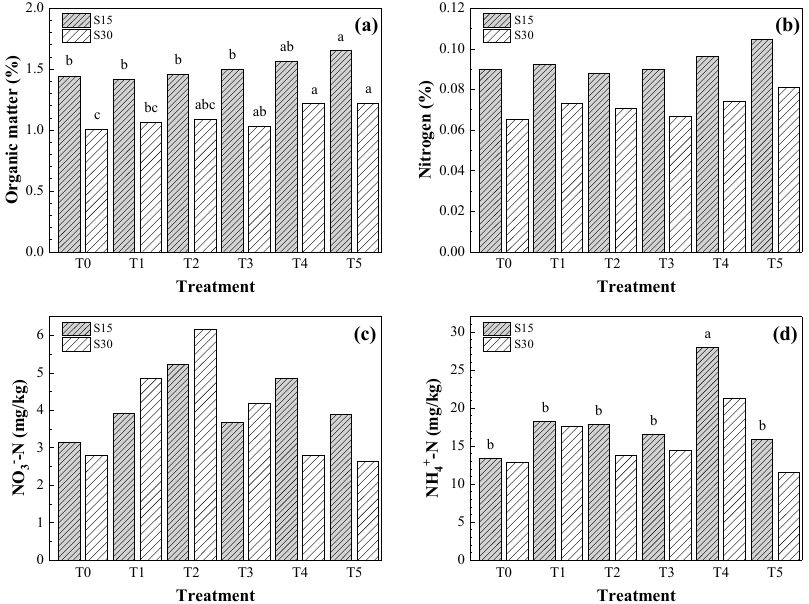
Figure 3. ( a ) Organic matter content (%); ( b ) nitrogen content (%); ( c ) NO 3 − -N content (mg · kg − 1 ); and ( d ) NH 4+ -N content (mg · kg − 1 ) at two different depths as a function of the different fertilization treatments after the three-year application period. Values are expressed as average values across four repetitions. S15 stands for 0 to 15 cm depth, S30 stands for 15 to 30 cm depth. Treatments followed by the same letter are not significantly different (Tukey’s test, significance at 0.05 level).